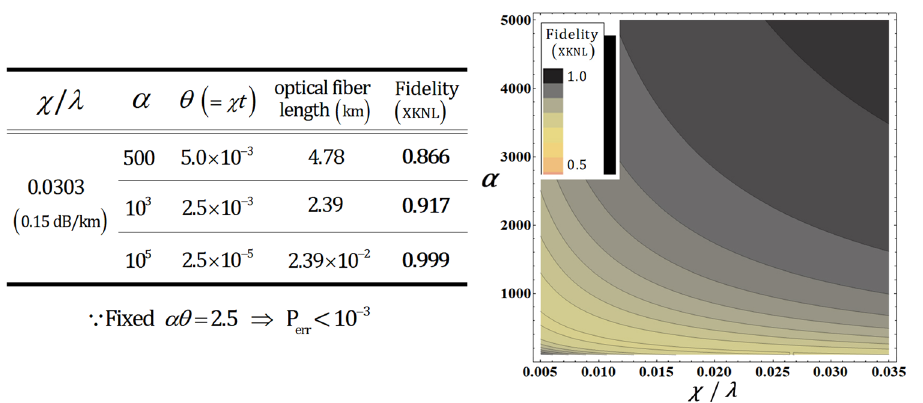
Figure 7. The left table is a list of the values of F XKNL for α = 500, 10 3 , and 10 5 in the optical fiber having χ / λ = 0.0303 (0.15 dB/km). The right plot represents F XKNL of the output state with respect to differences in the amplitude of the coherent state ( α ) and the signal loss χ / λ in the optical fiber. Here we take the parameter < 10 − 3 αθ = 2.5 for the error probability P err